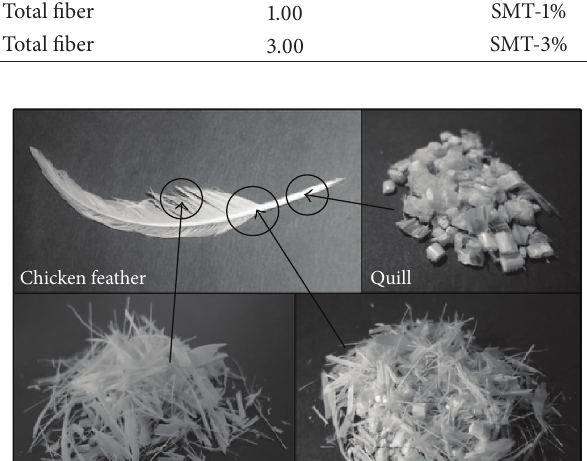
Figure 2: Graphic explanation of swelling